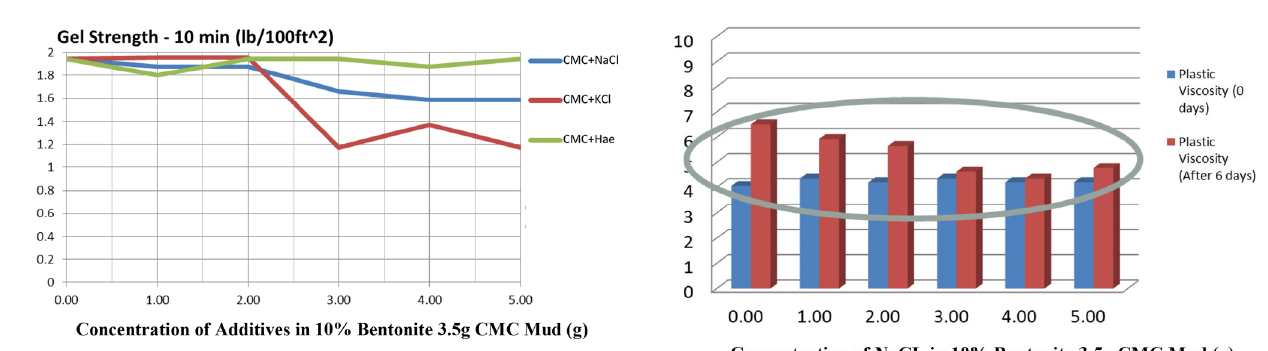
Fig. 11 Effect of NaCl on plastic viscosity of CMC–bentonite mud in accordance with time